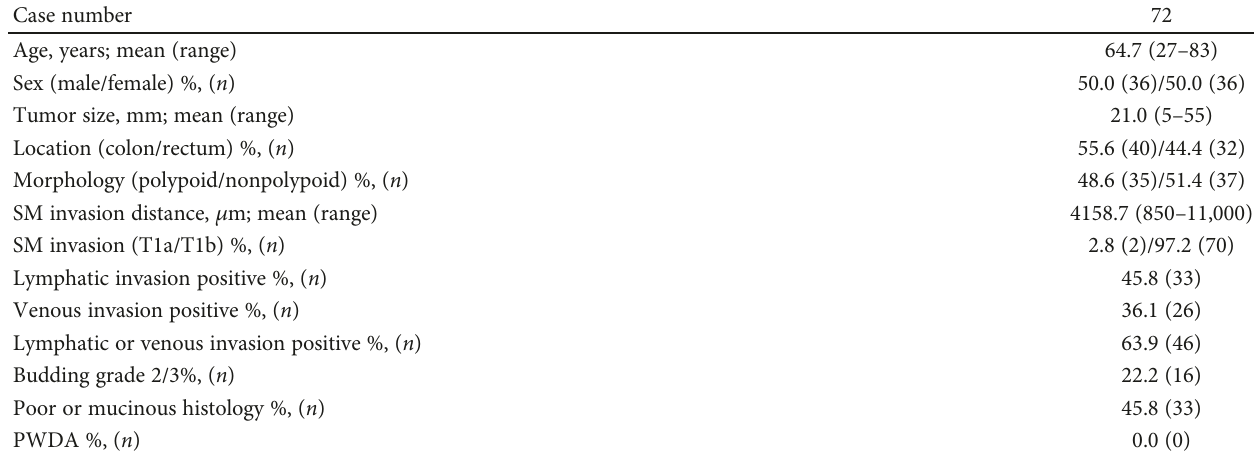
Table 6: A multicenter review analyzing 72 T1 cancers with LNM.